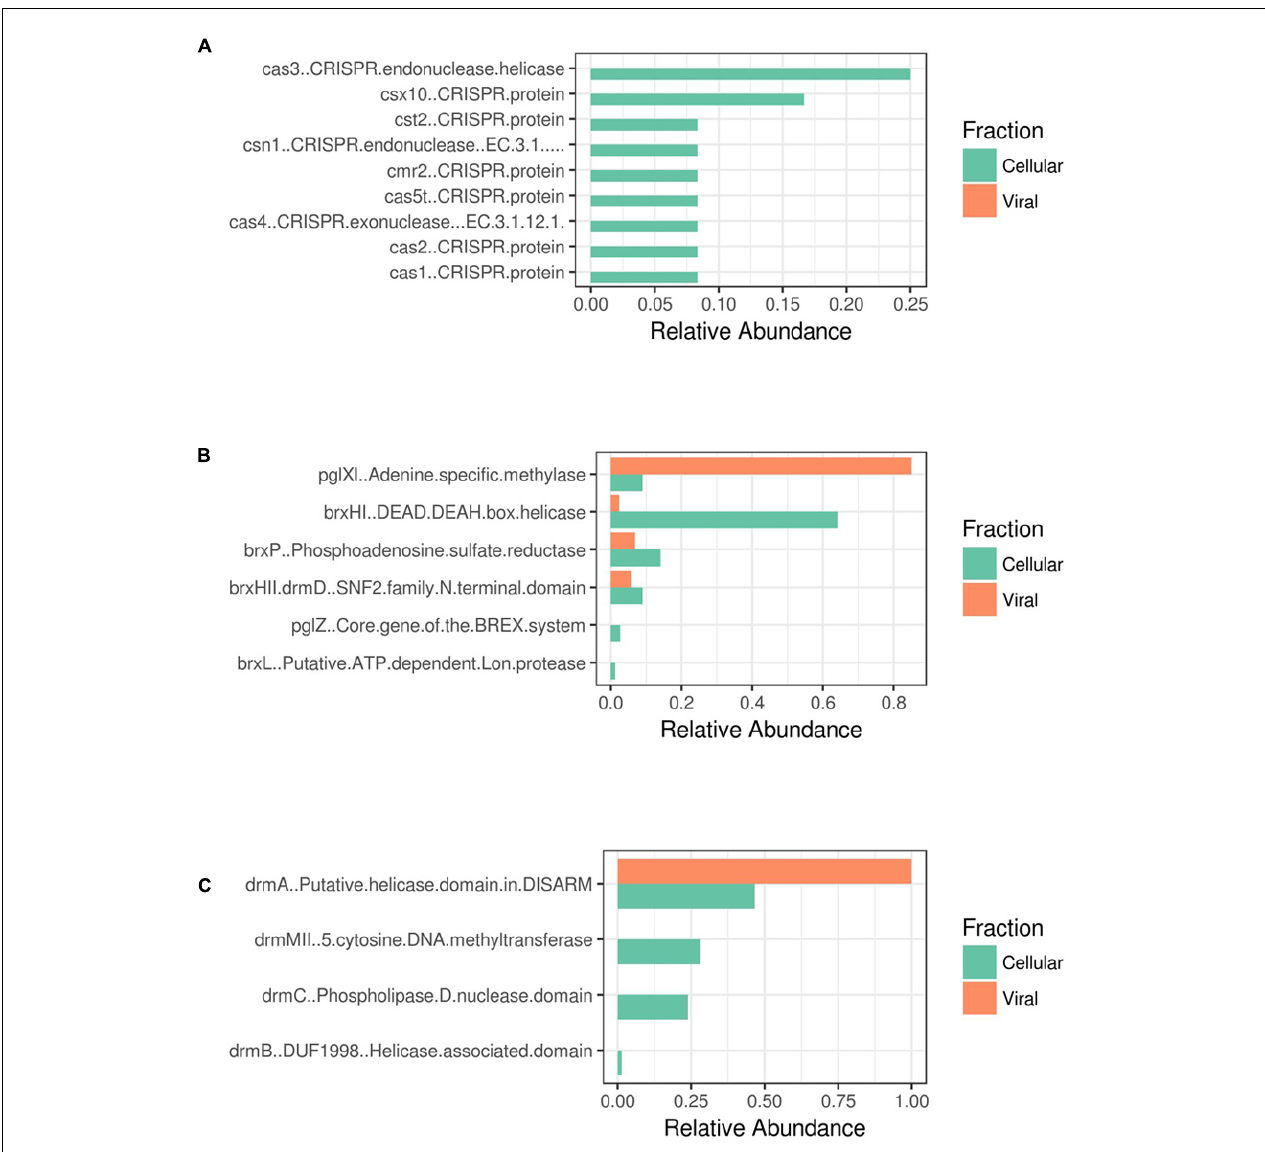
FIGURE 3 | Antiviral resistance genes amongst Shark Bay viral and cellular fraction. (A) CRISPR-Cas associated genes (B) BREX associated genes (C) DISARM associated genes. The relative abundance is the number of hits from GhostKoala and the Pfam database using InterProScan 5.